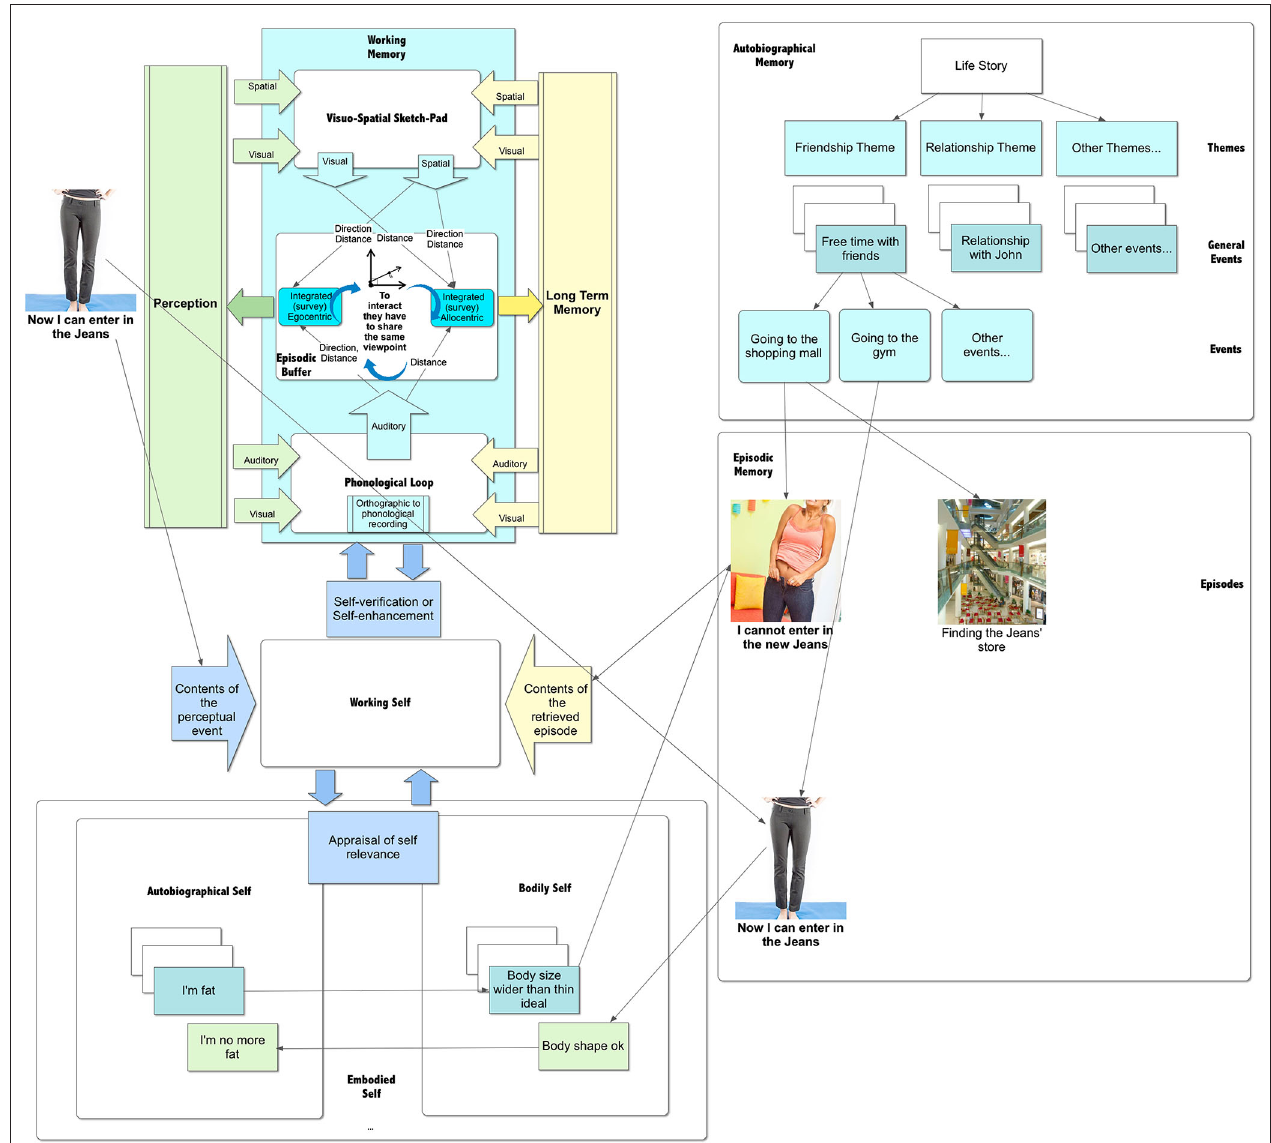
FIGURE 3 | Updating the contents of episodic memory